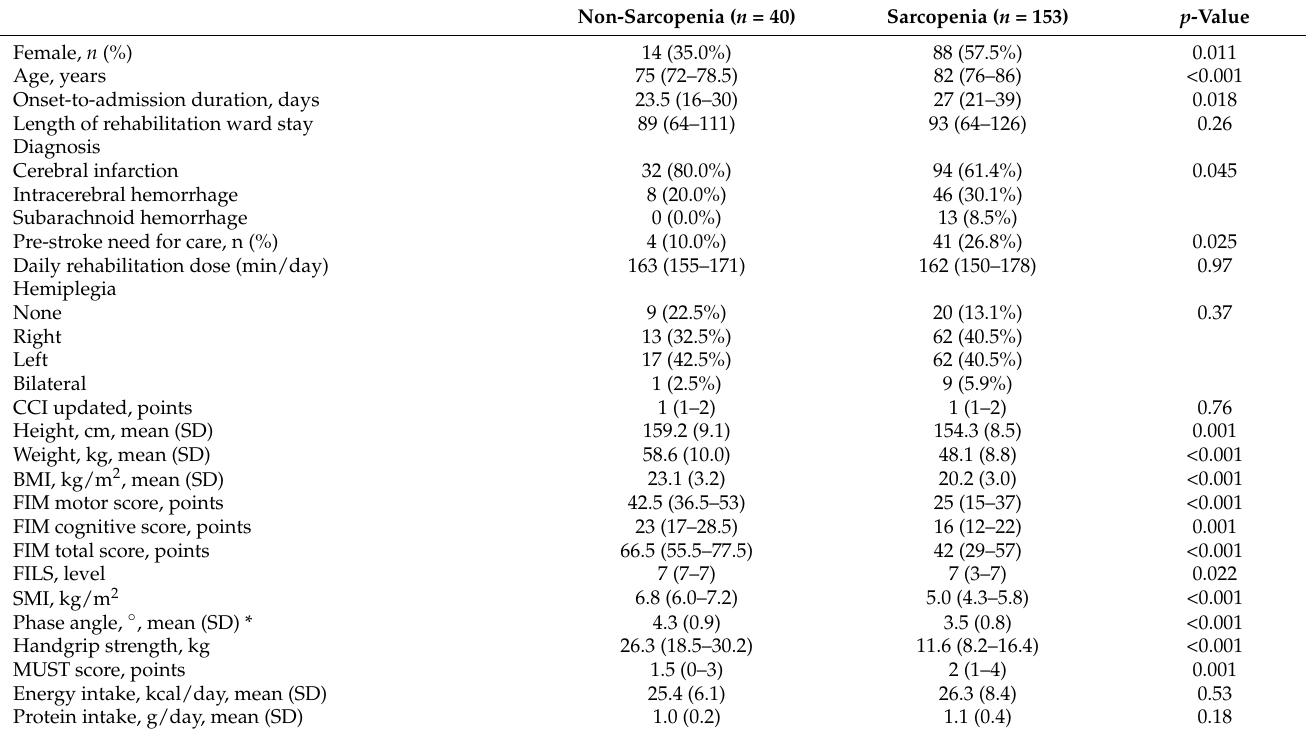
Table 1. Baseline characteristics of 193 stroke patients with dysphagia in convalescent rehabilitation wards.